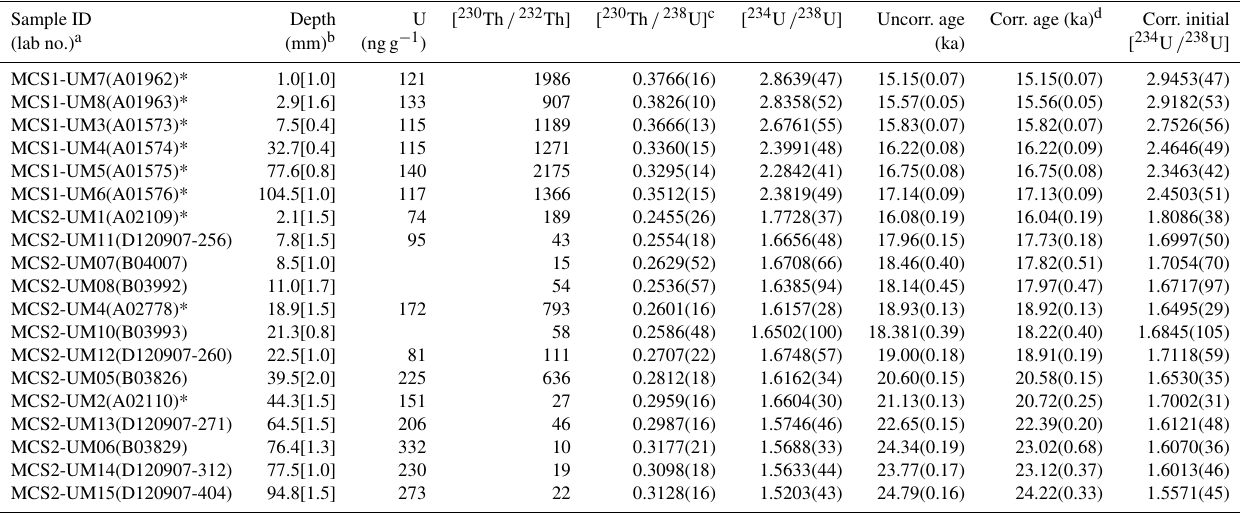
Table 1. U and Th isotope data and age determinations (in depth order) for stalagmites MC-S1 and MC-S2, Mairs Cave, Flinders Ranges, South Australia. Square brackets indicate activity ratios. MCS2-UM10 was omitted from the age–depth model as it is out of stratigraphic